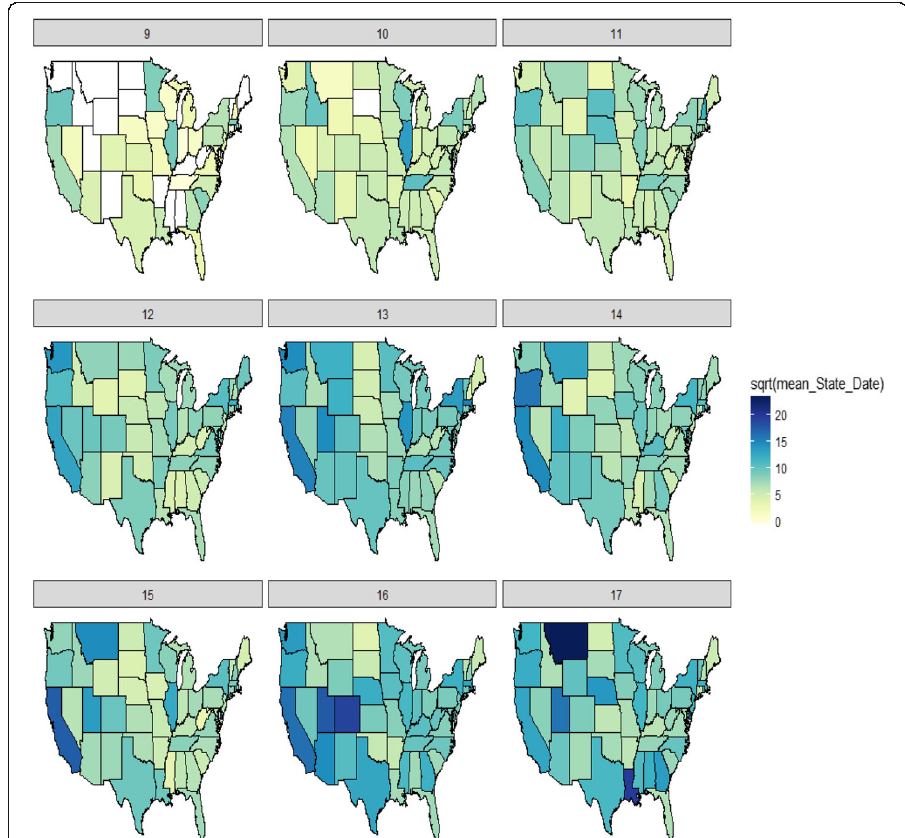
Fig. 7 Maps of observed mean backers per state over the years